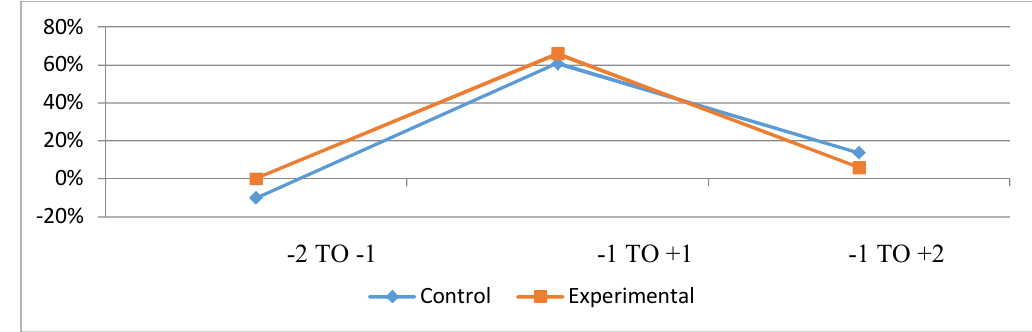
Fig. 4. Stock Prices Changes on Experimental and Control